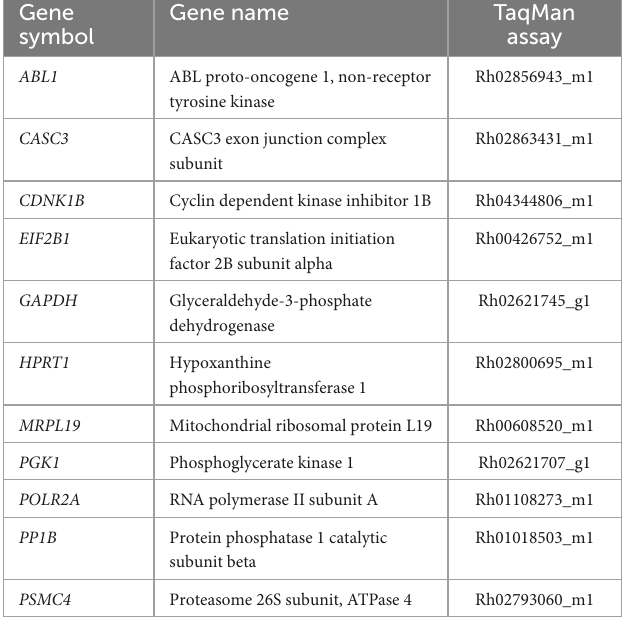
TABLE 2 Human BDNF variant